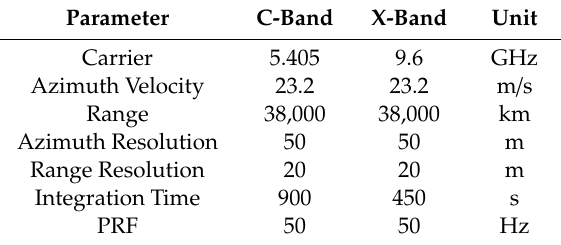
Table 1. GEO SAR system characteristics for scene decorrelation impact simulation.